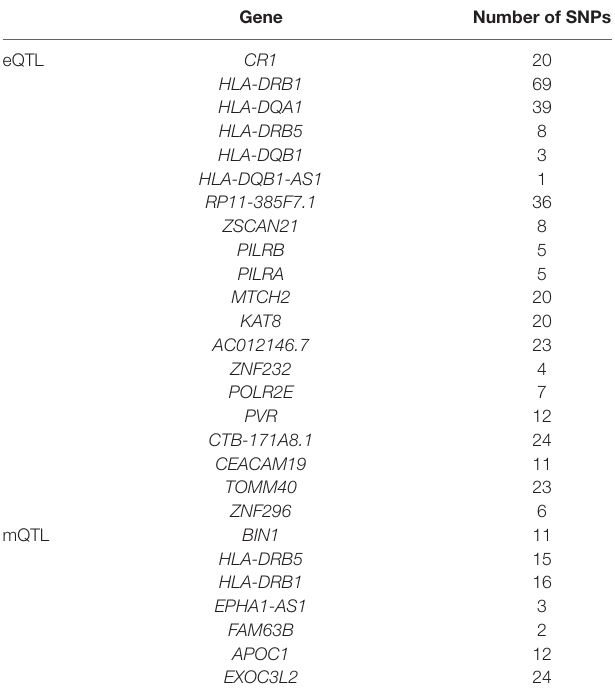
TABLE 3 | The candidate genes selected by summary data-based Mendelian randomization (SMR).